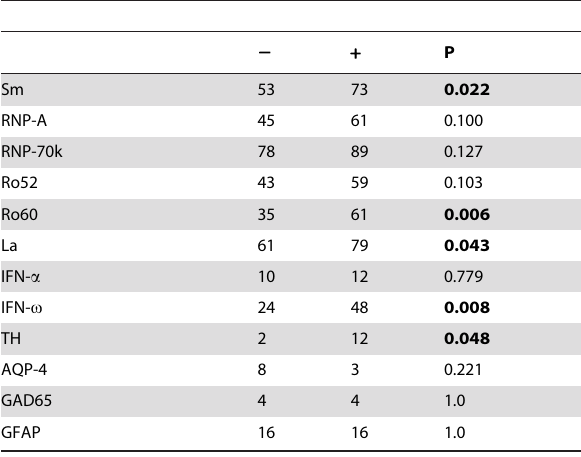
Table 7. Percentage of seropositive patients by anti-dsDNA antibody status.